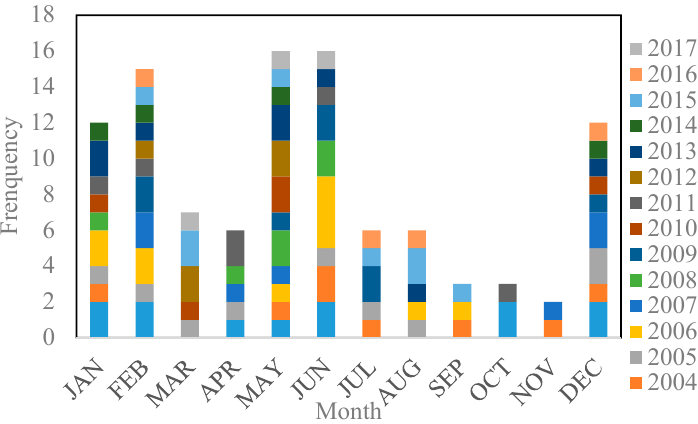
Figure 4. Time distribution of the MODIS images used.